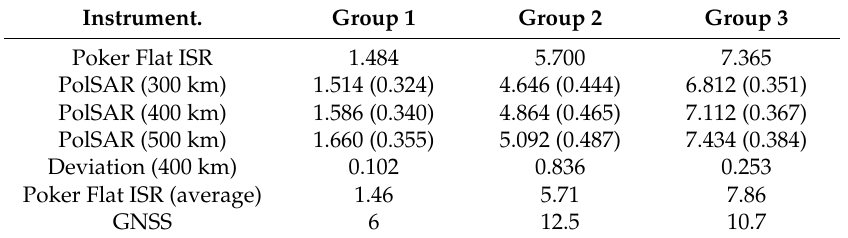
Table 3. TEC measurements of Poker Flat ISR and PolSAR. GNSS: Global Navigation Satellite System.